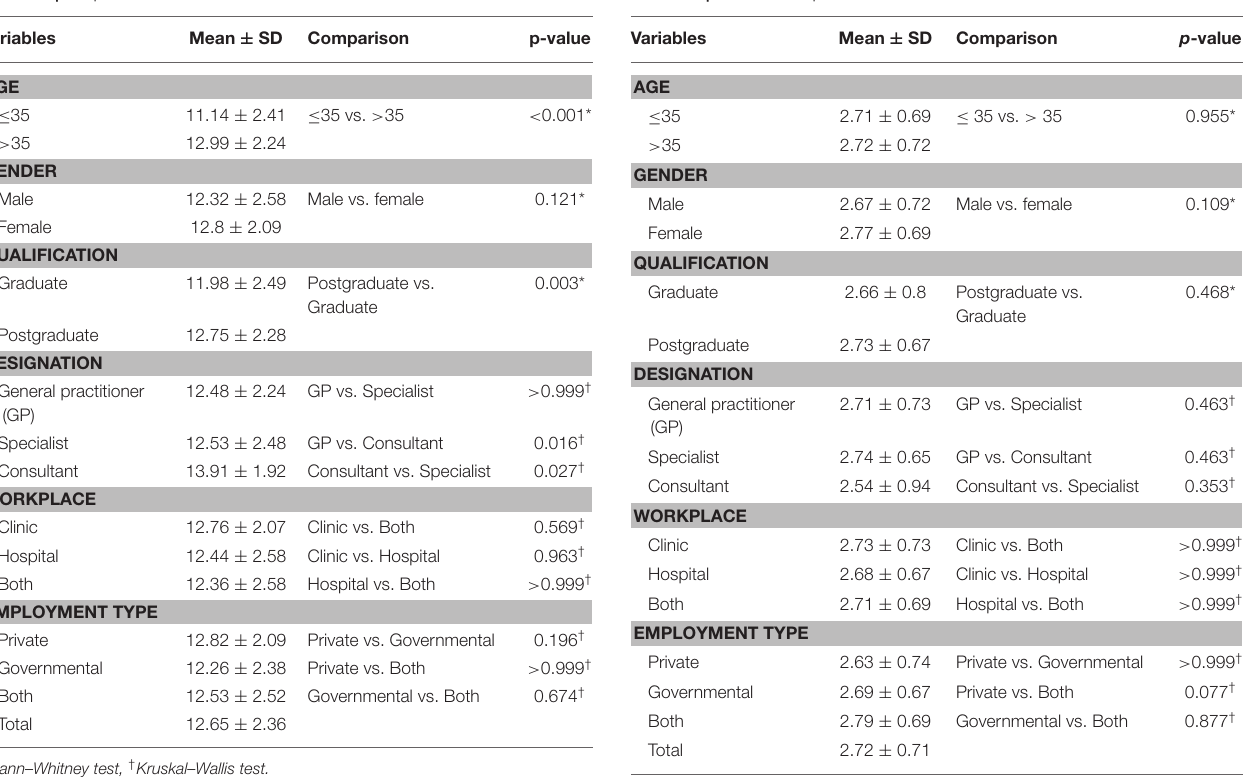
TABLE 4 | Respondents’ awareness of COVID-19 infection-control measures. TABLE 5 | Economic impact of the COVID-19